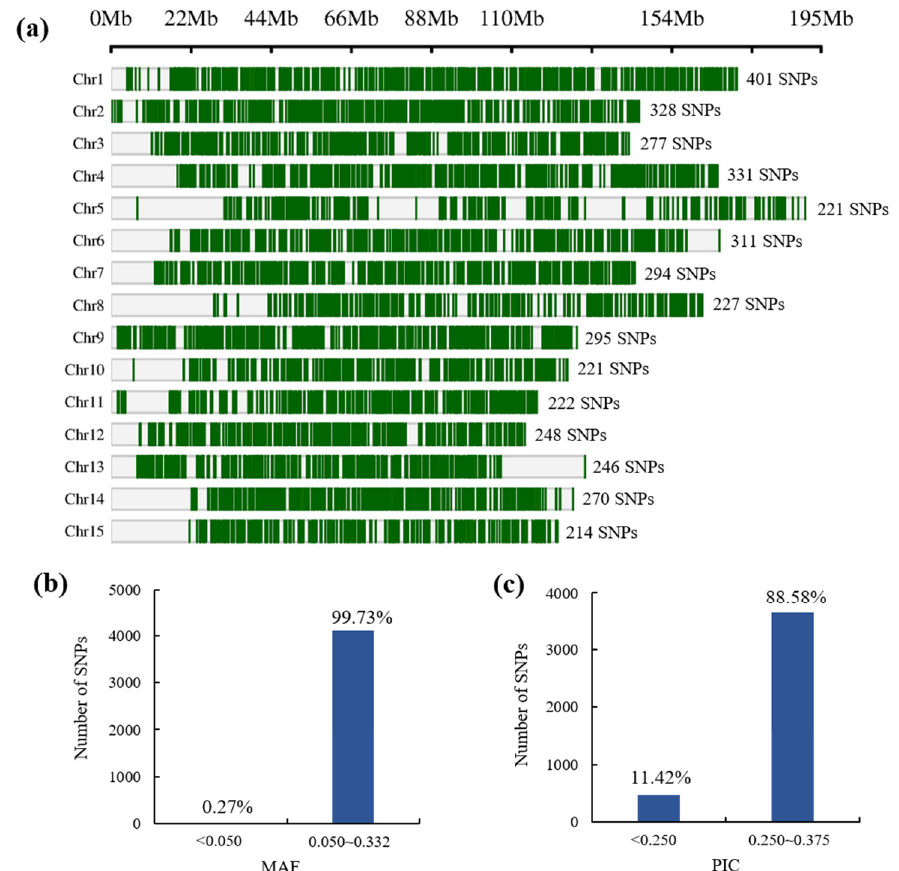
Figure 2. Genomic location distribution and MAF and PIC values of 4115 SNP loci: ( a ) genomic location distribution of all SNP loci; the number represents the number of markers on the chromosome; ( b , c ) distribution of the respective MAF and PIC values of the SNP loci.